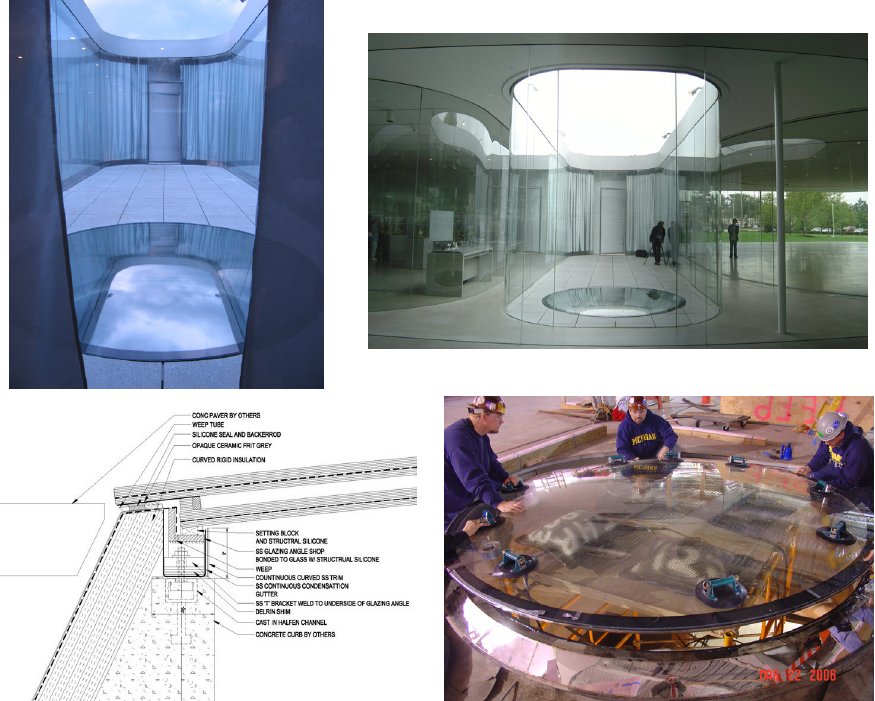
Figure 12a, b, c, d: Oculus Skylight, Context View, Section Detail, Installation